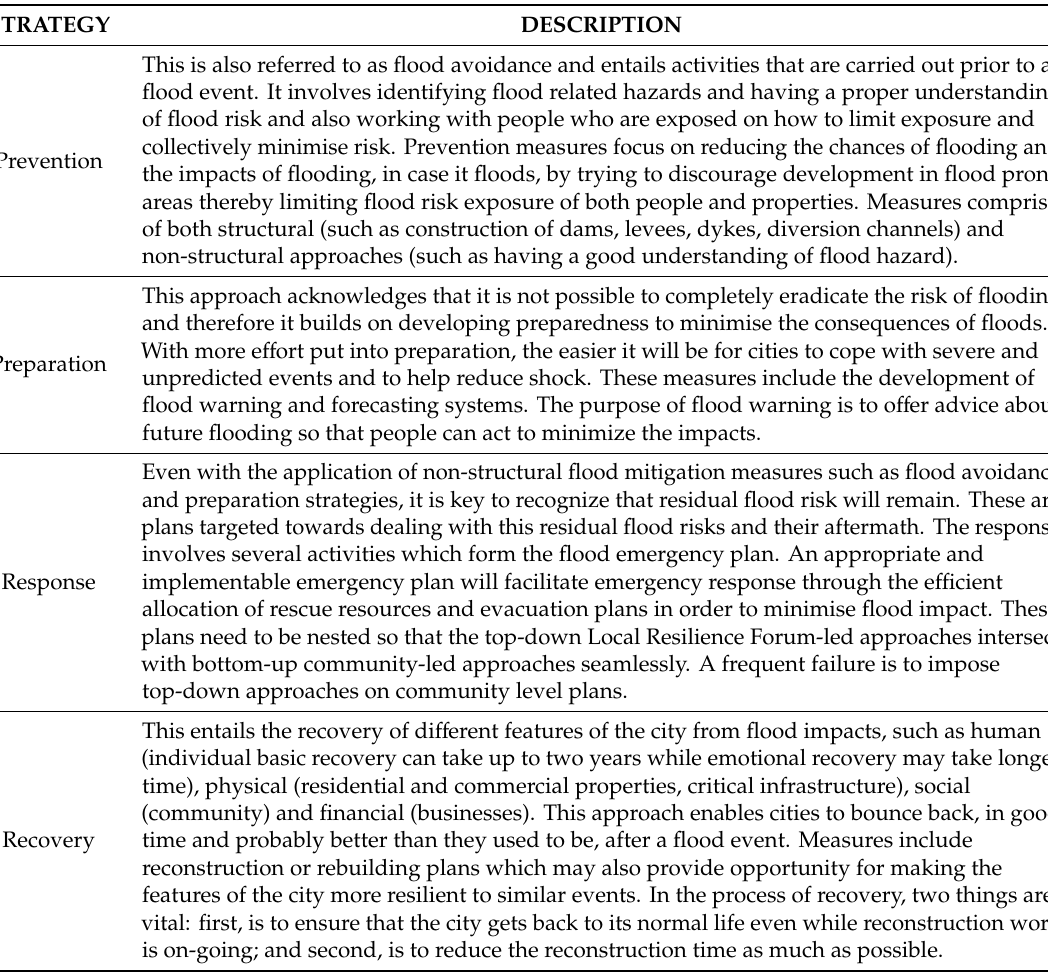
Table 1. Four types of flood risk management